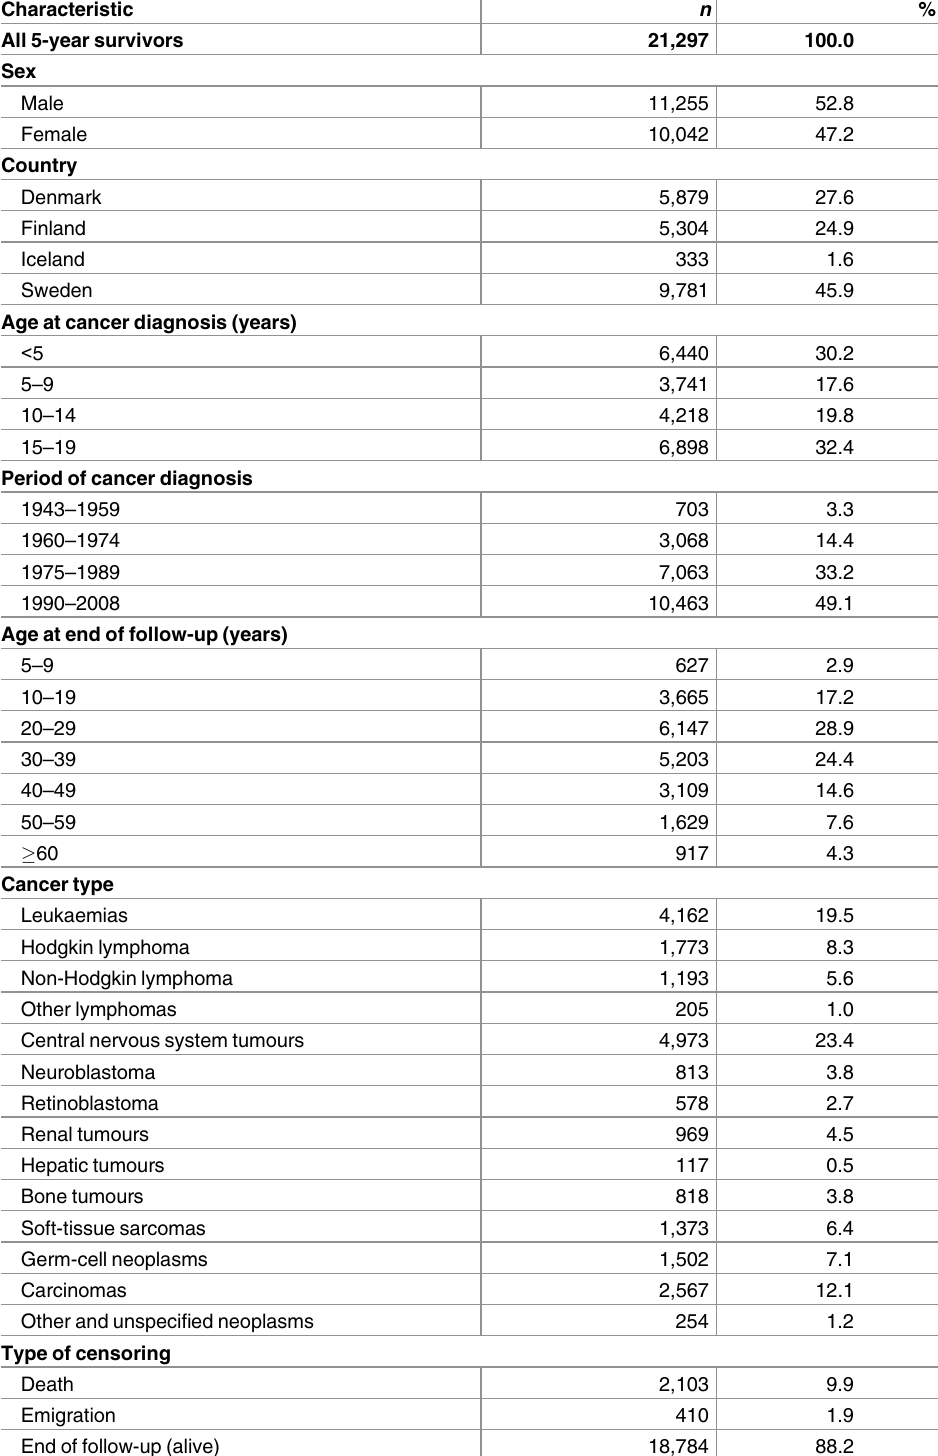
Table 1. Characteristics of the study population of 21,2975-year childhood cancer survivors in four Nordic countries.